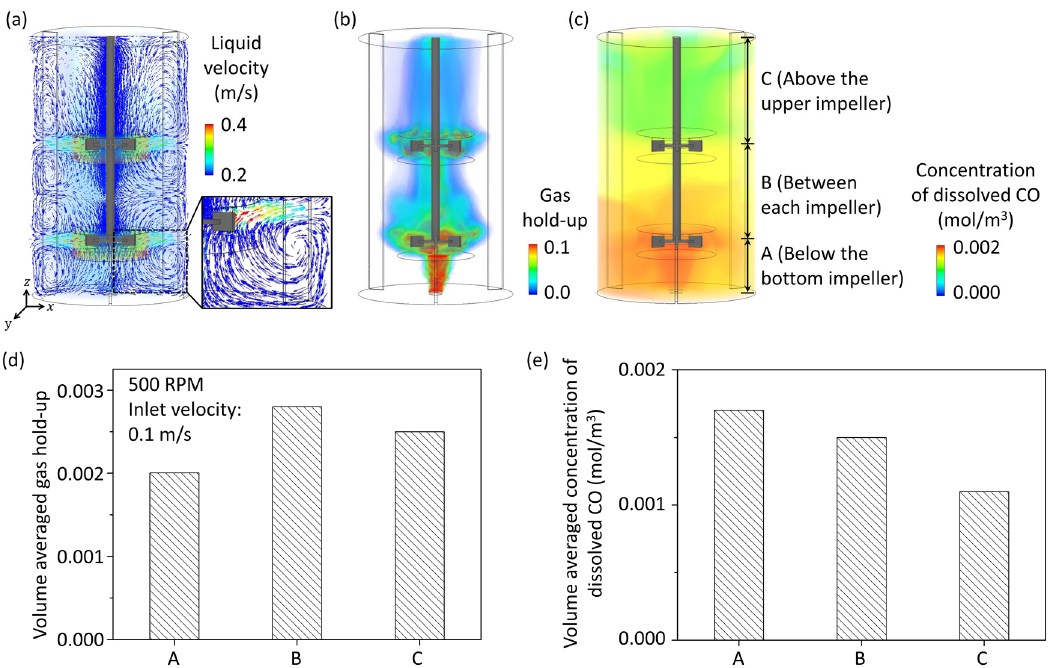
Figure 2. ( a ) Velocity vectors in y = 0 m plane. Contour of the ( b ) gas hold-up and ( c ) dissolved carbon monoxide concentration with a rotational speed of 500 RPM and an inlet velocity of 0.1 m/s. ( d ) Volume averaged gas hold-up and ( e ) dissolved carbon monoxide concentration in three regions. A: below the bottom impeller, B: between each impeller, and C: above the upper impeller.